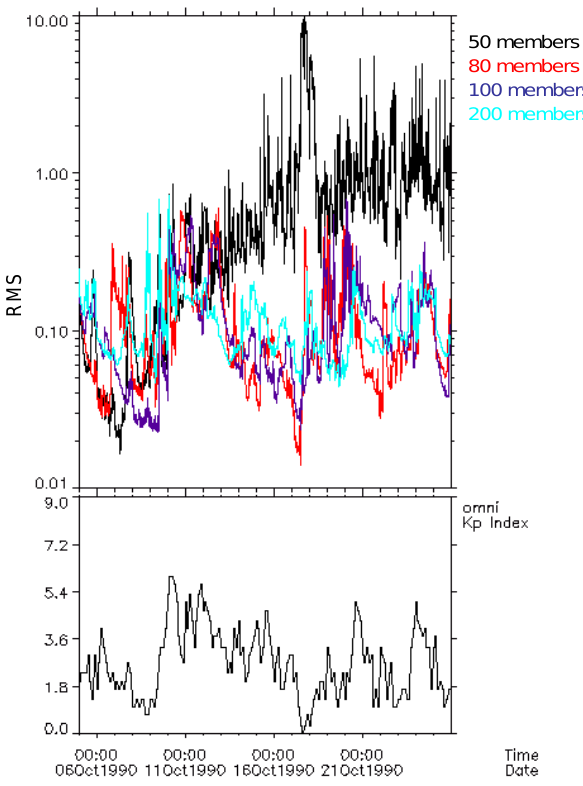
Fig. 9. Root mean square deviation of the logarithm of phase space densities averaged over the entire simulation domain ( E , α eq , L ∗ ) for various size of ensemble (top panel), and magnetic activity index Kp (bottom panel).